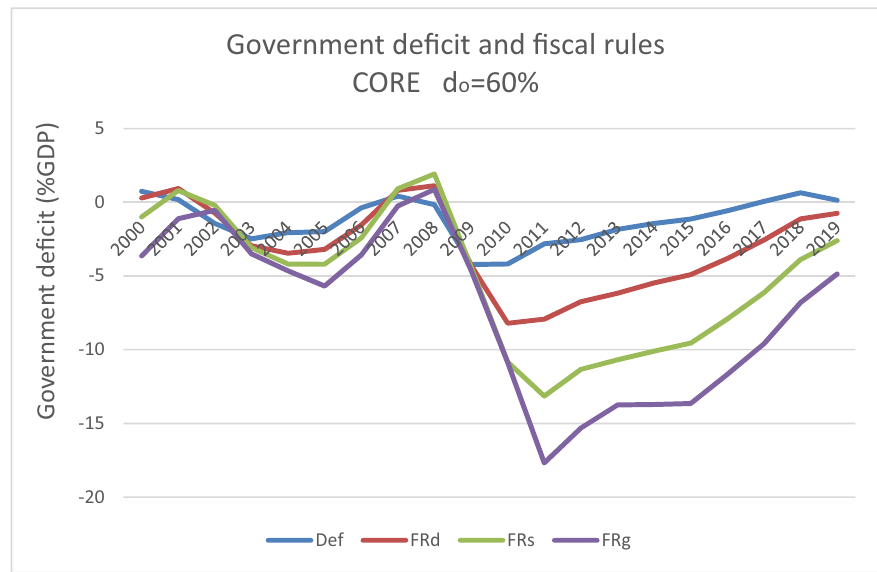
Figure 2.2: CORE countries government de fi cit ( Source: Own elaboration from data on Table 2 )